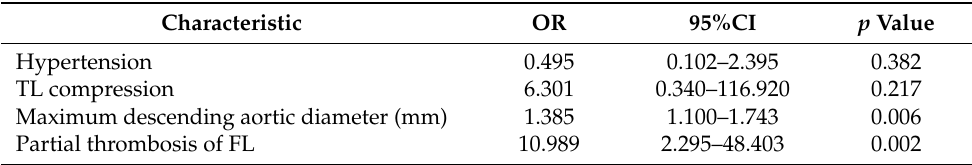
OR: odds ratio; CI: confidence interval; TL, true lumen; FL, false